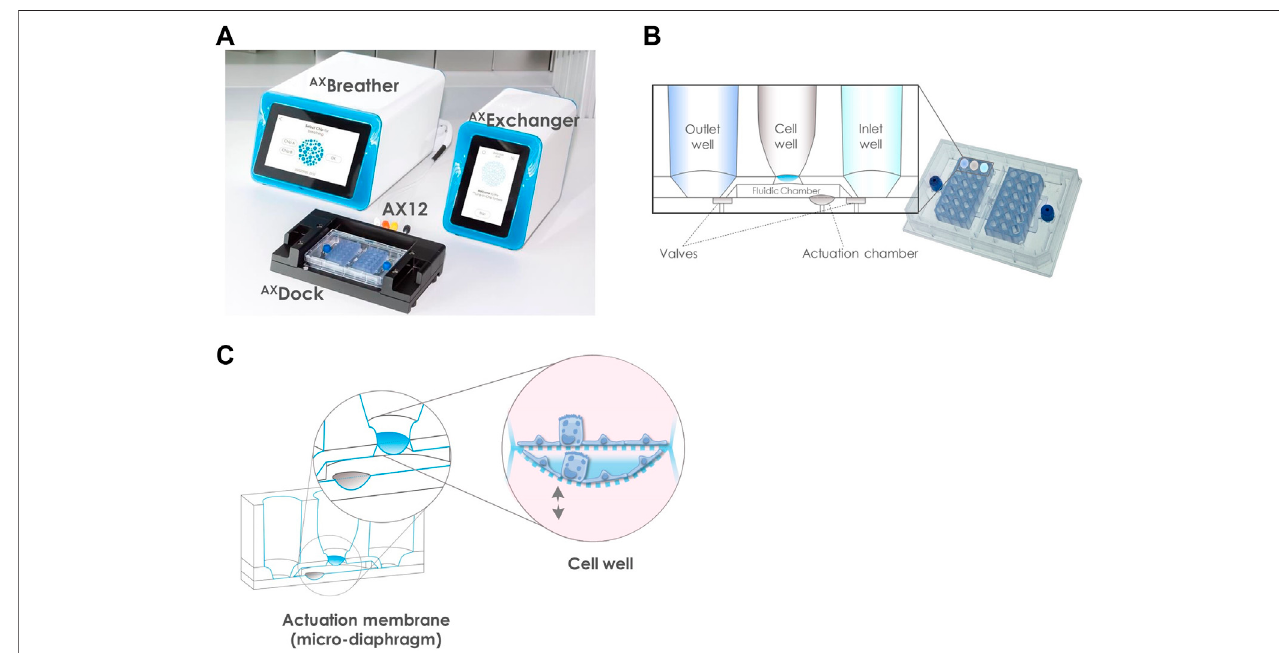
FIGURE 1 | Overview of the AX Lung-on-chip System. (A) including the Lung-on-chip (AX12), two electro-pneumatic modules: AX Exchanger and AX Breather, and the interface platform: AX Dock. (B) Detail of the AX12 comprised of two chips. Based on a SBS footprint (standard 96-well plate layout 127 mm × 85 mm), the wells are positioned at equal distance of 9 mm. The chip cross-section schematic shows that one unit comprises of an inlet and an outlet well, connected through micro fl uidic channels and pneumatic valves tothe cell compartmentwith the3.5 µm ultrathin membraneof porous density 8 ×10 5 pores/cm 2 (blue). The two valves de fi ne the medium fl owviathecontrolofthe AX Exchanger,forwhich200 µlofmediumarepipettedintheinletwells. (C) Principleofthebreathingfunction.Inthe fl uidicchamberofa volume ~80 μ l, the actuation membrane (grey), acting as a micro-diaphragm, is cyclically stretched in 3D by the AX Breather. This movement is transferred to the cells cultured on the cell well membrane (blue). The cell barrier recreated on the ultrathin porous membrane is biomechanically stimulated with a physiological 3D-stretch of 10% linear strain and 0.2 Hz frequency.